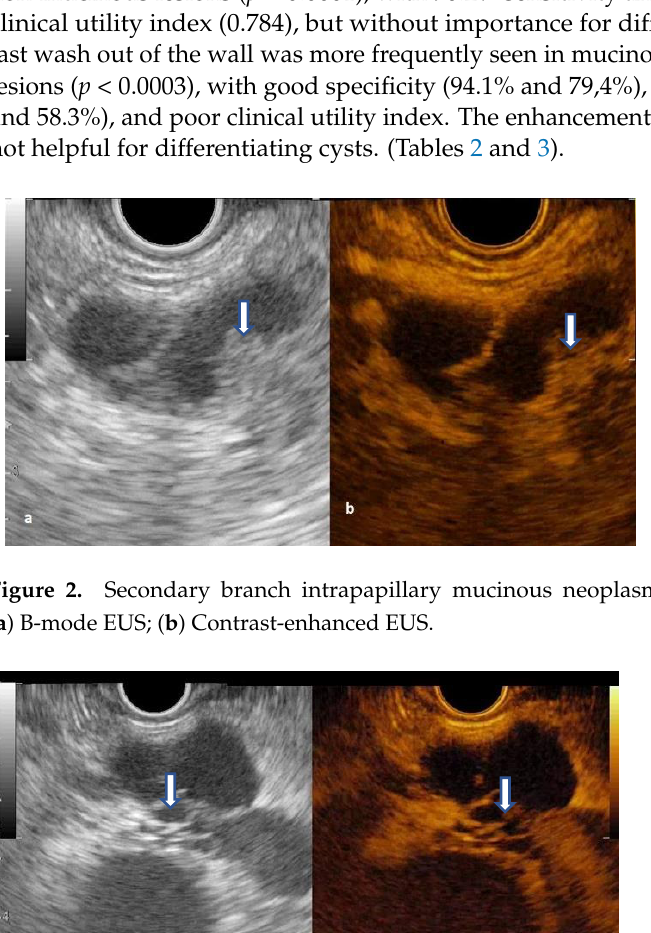
Figure 5. Branch-duct IPMN with mural nodule ( a ) B-mode EUS; ( b ) CH-EUS-FNA from the mu- ral nodule (arrow). Table 2. CH-EUS features: mucinous vs. non-mucinous and malignant vs. non-malignant pancreatic cysts. Cyst Feature